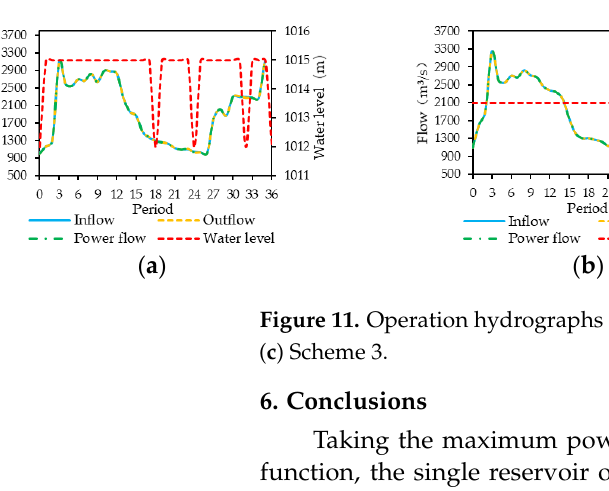
Figure 10. Operation hydrographs of Ertan Reservoir using ( a ) Scheme 1, ( b ) Scheme 2 and ( c ) Scheme 3 respectively.